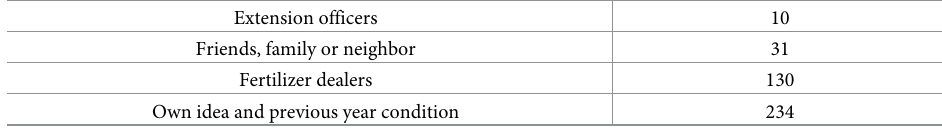
Table 5. The potential bases for the farmers’ decision-making in fertilizer